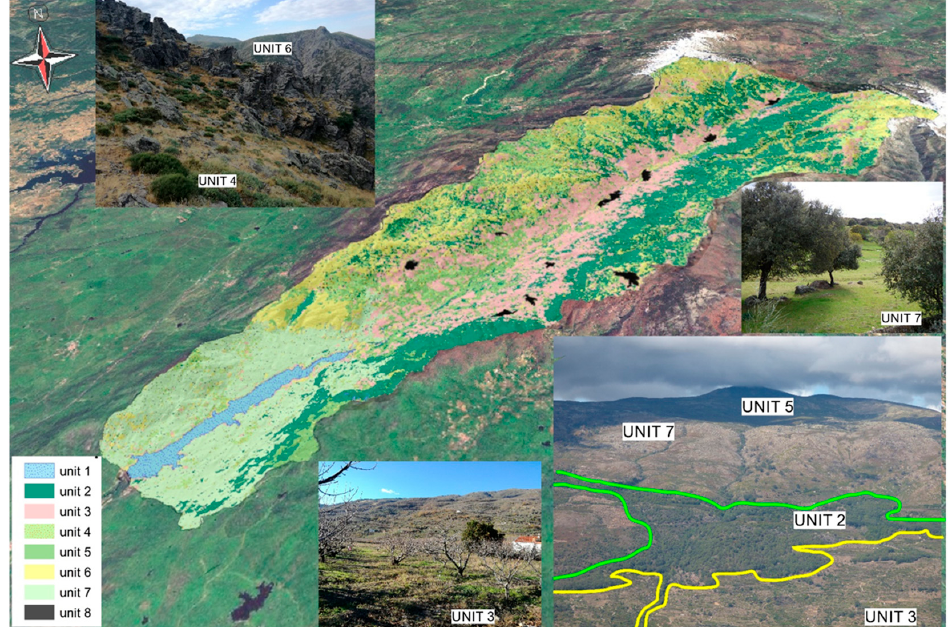
Figure 3. 3D modeling of landscape units with reconnaissance field images of the most representative landscape units.